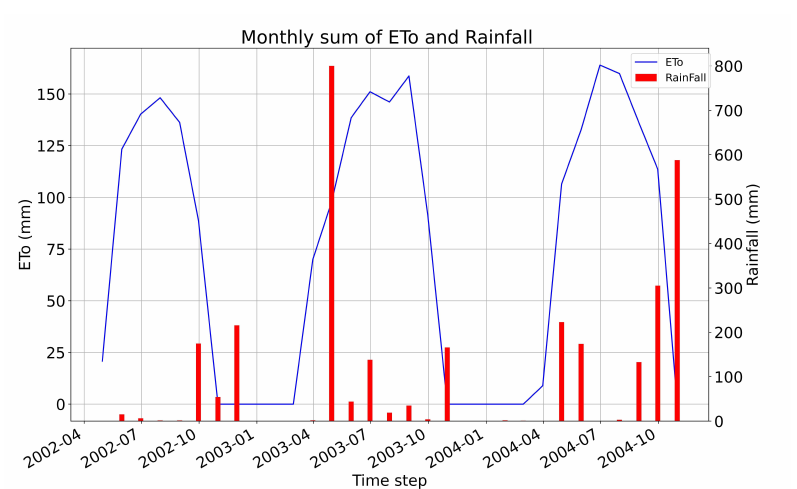
Figure 10. Monthly sum of rainfall and estimated ETo for Quinta de Pancas from 2002 to 2004.